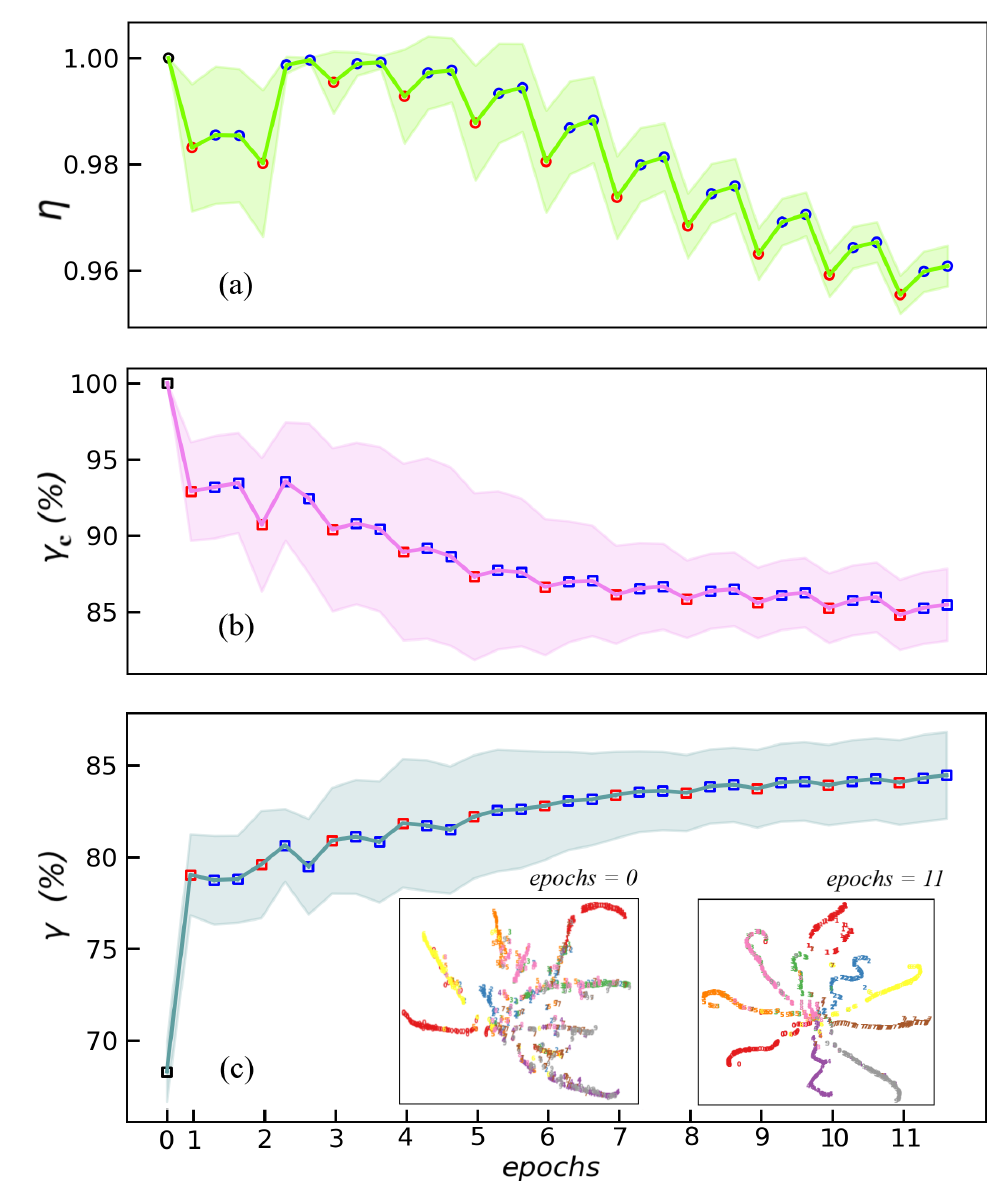
Figure 5. For the RLF-NSSL on the MNIST dataset with N = 6 labeled samples in each class (few- shot case), ( a , b ) show the confidence η and classification accuracy γ c of the samples in the clusters, respectively, in different epochs. ( c ) shows the classification accuracy γ for the testing set. The insets of ( c ) illustrate the visualizations by applying t-SNE to the testing samples in the low-dimensional space (Equation (5)). See the details in the main